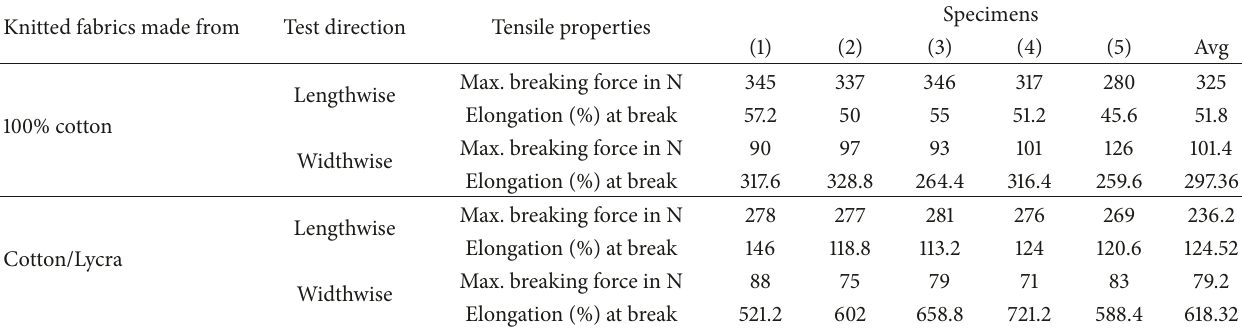
Table 6: Tensile properties of 1 × 1 rib knitted fabrics.